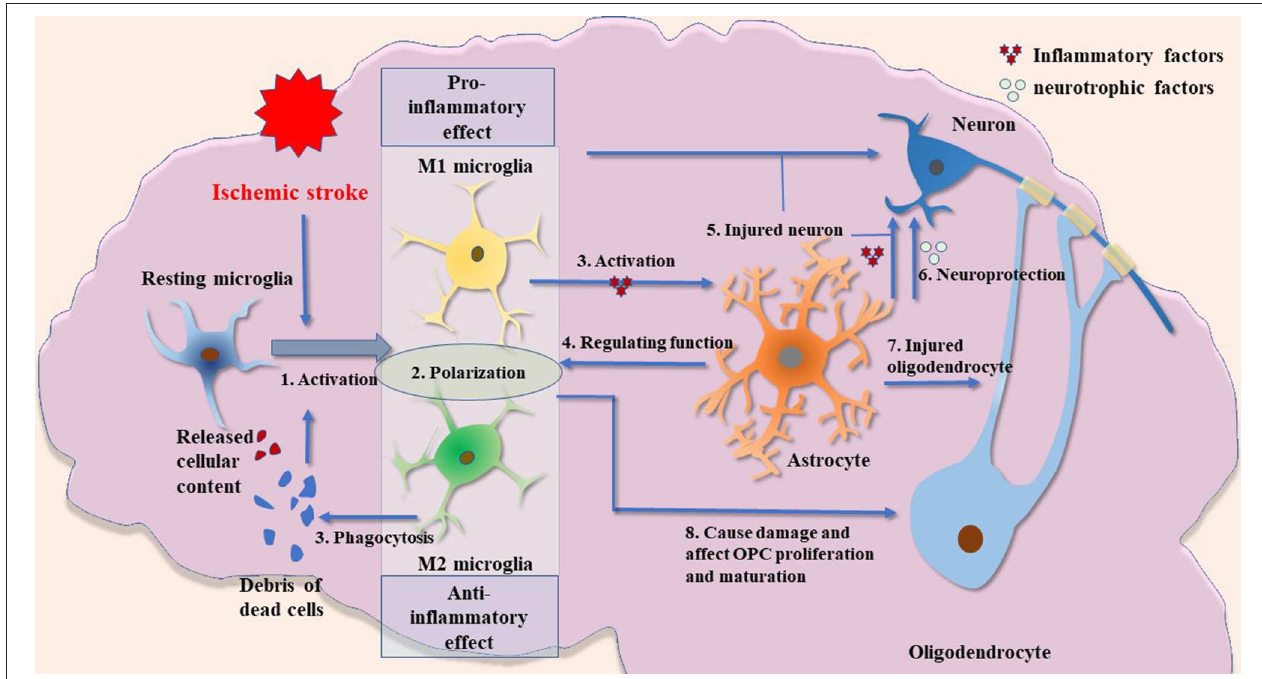
FIGURE 1 | Possible crosstalk between glial cells in ischemic stroke. (1) Microglial activation is an important process in inflammatory response after ischemic brain injury. The release of cellular contents and debris from dead cells, such as other glial cells and neurons, can cause microglial activation. These fragments will also be engulfed by microglia. (2) The M1 and M2 microglia have significantly different biological functions. In short, M1 microglia have a stronger proinflammatory phenotype, whereas M2 microglia are anti-inflammatory and have a robust function in phagocytosis. M1 and M2 microglia described in this paper are the two most widely studied types. Other types of microglia and their biological function need to be further explored. (3) Activated microglia induce the activation of astrocytes by releasing cytokines such as IL1 α , TNF α , and C1q. (4) Astrocytes have a regulatory effect on microglia by releasing cytokines such as IL-33. (5) Activated microglia and astrocytes can damage neurons. (6) Astrocytes may have neuroprotective functions by producing several types of neurotrophic factors. (7) Activated astrocytes have damaging effects on oligodendrocytes. (8) Microglia may have a dual role in the regulation of oligodendrocytes: inflammatory factors produced by activated microglia cause impairment of oligodendrocyte/OPCs, whereas VEGF-C produced by microglia stimulates OPC proliferation and M2 microglia can drive oligodendrocyte differentiation during remyelination.